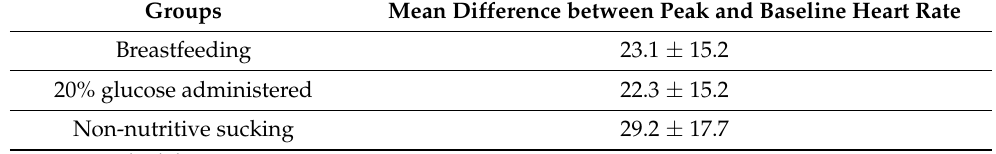
Table 8. The difference between the peak and the initial heart action in the groups of newborns. Groups Mean Difference between Peak and Baseline Heart